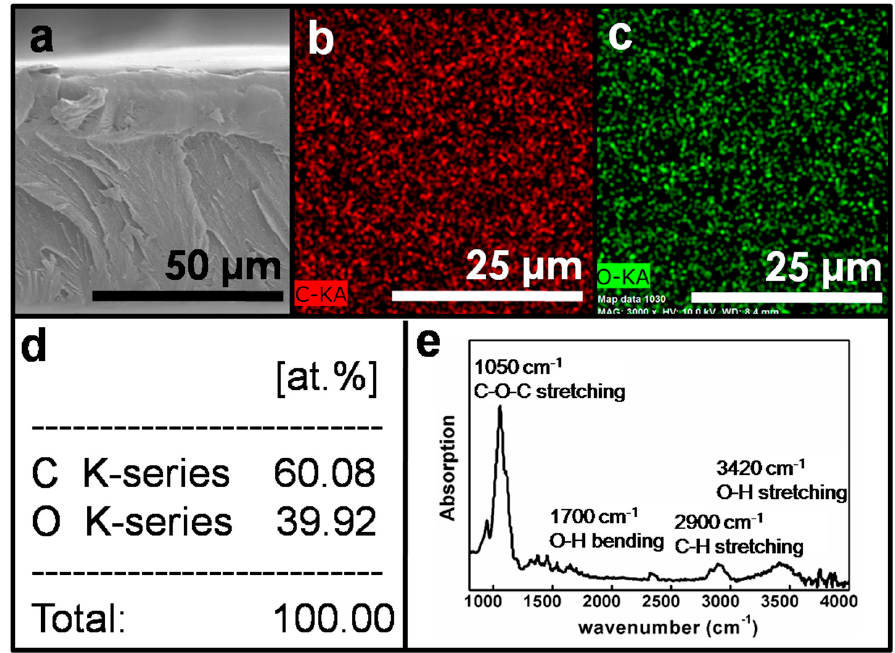
Figure 2. ( a ) Scanning electron microscopy (SEM) image of a cross-section of HPMC film; energy-dispersive X-ray spectroscopy (EDS) map of ( b ) carbon; ( c ) oxygen; ( d ) EDS analysis of a cross-section of HPMC film; ( e ) the Fourier transform infrared spectroscopic (FTIR) analysis of cross-section of HPMC film.